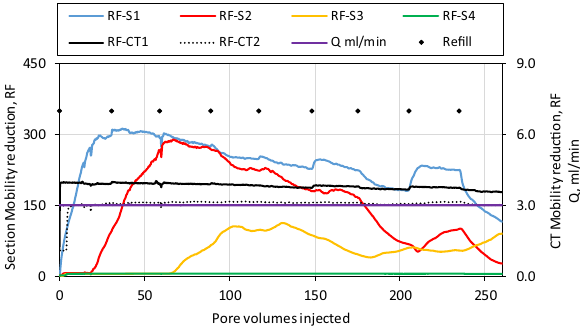
Fig. 13 Experiment 6, 1000 ppm A10 in SSW in Berea cores. RF pm as a function of pore volumes injected. T1 = 20 °C, T2 = 60 °C and T3 = 80 °C. The volumetric injection rate is 0.5 ml/min ( ̇𝛾 pm ∼ 67s − 1 , ̇𝛾 ct = 82.5s − 1 ) from 0 to 127.5 pore volumes, and 0.2 ml/min from 127.5–157 pore volumes, 0.1 ml/min from 157–211 pore volumes and 0.5 ml/min from 211–220 pore volumes